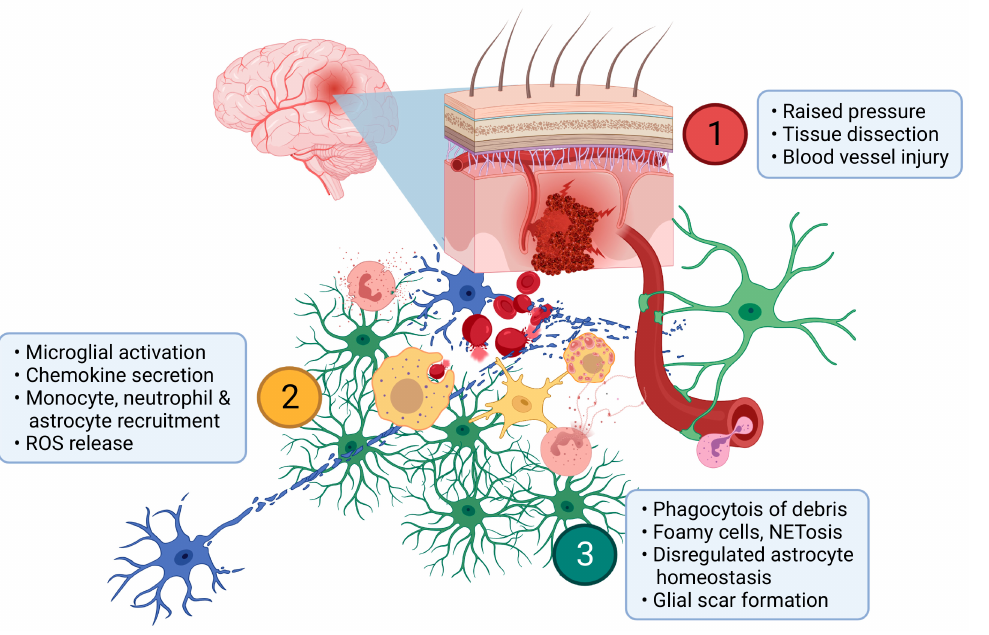
Figure 1. Pathophysiology of ICH. ( 1 ) Haemorrhage from a parenchymal arteriole drives pressure gradients that dissect neural tissue (blue) and may cause distant injury as well as blood vessel injury. ( 2 ) Myelomononuclear cells (yellow) rapidly respond by release of proinflammatory cytokines and other chemokines. These serve to recruit MdCs, astrocytes (green) and neutrophils (amber) which secrete further inflammatory mediators and reactive oxygen species (ROS). ( 3 ) As inflammation pro- gresses, debris is progressively phagocytosed and foamy myelomononuclear cells appear. Neutrophil NETosis may serve to limit haemorrhage and/or microvascular blood flow. As astrocytes respond to the ICH and contribute to glial scar formation, their homeostatic functions including neurovascular and neurometabolic coupling are impaired. Created with